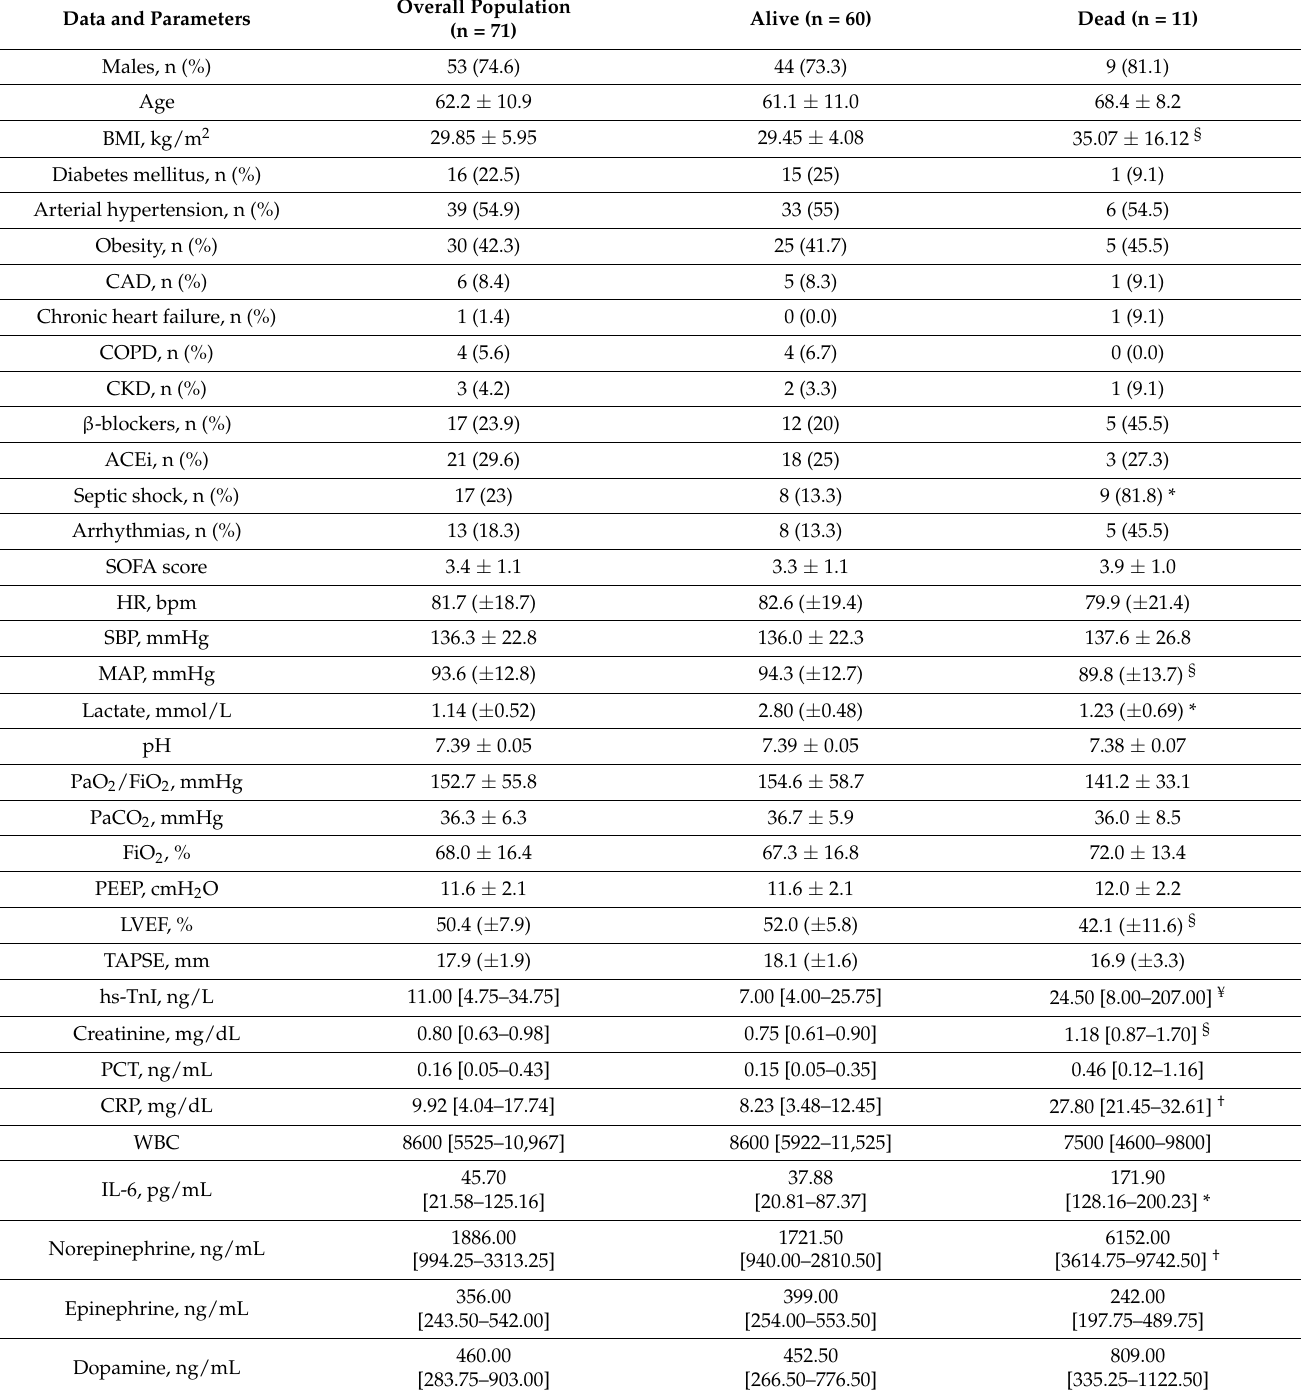
Table 1. Comparison of clinical features, echocardiographic parameters, inflammatory markers, and serum catecholamine levels between alive and dead